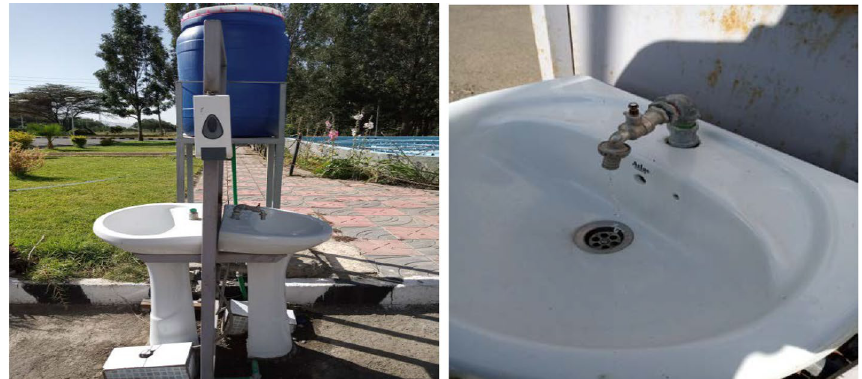
Fig. 2 Elevated hand wash con- structed inside ASTU campus after COVID-19